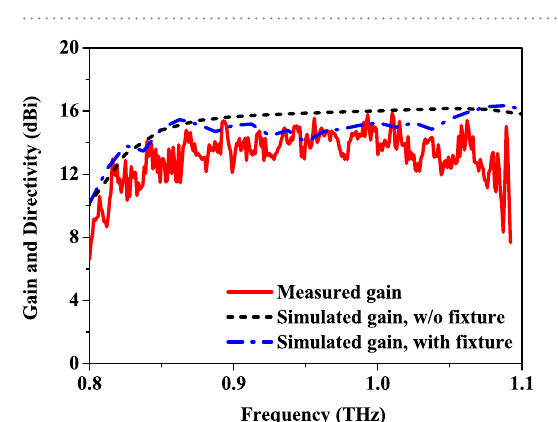
Figure 11. Measured and simulated radiation pattern of the antenna array. ( a ) f = 0.85 THz, E-plane, ( b ) f = 0.95 THz, E-plane, ( c ) f = 1.05 THz, E-plane, ( d ) f = 0.85 THz, H-plane, ( e ) f = 0.95 THz, H-plane, and ( f ) f = 1.05 THz, H-plane.